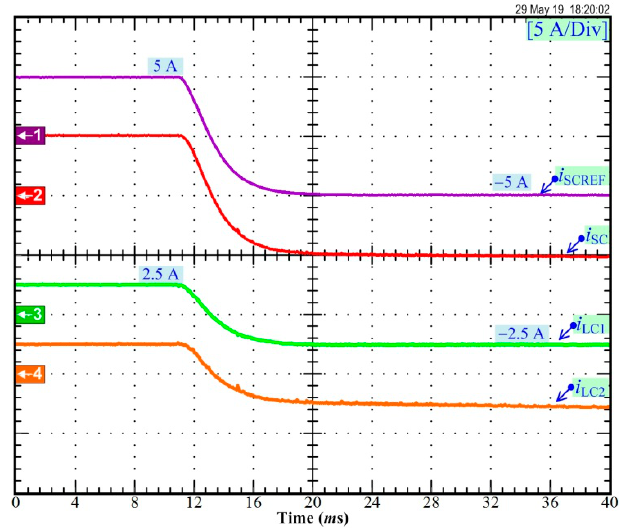
Figure 10. Experimental results: SC current response during i SCREF changing from 5 A (discharging) to − 5 A (charging).